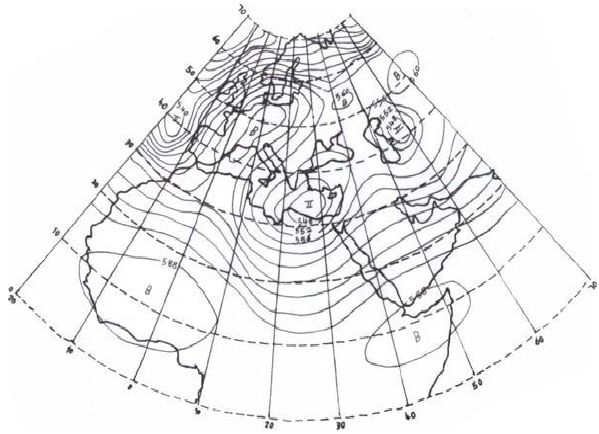
Fig. 11 The pattern of the geopotential heights and the LA center at 500 hPa before Fig. 11. The pattern of the geopotential heights and the LA center at 500hPa before the heavy rainfalls (type III: 15 February 1988). the heavy rainfalls (Type III: 15 February 1988)